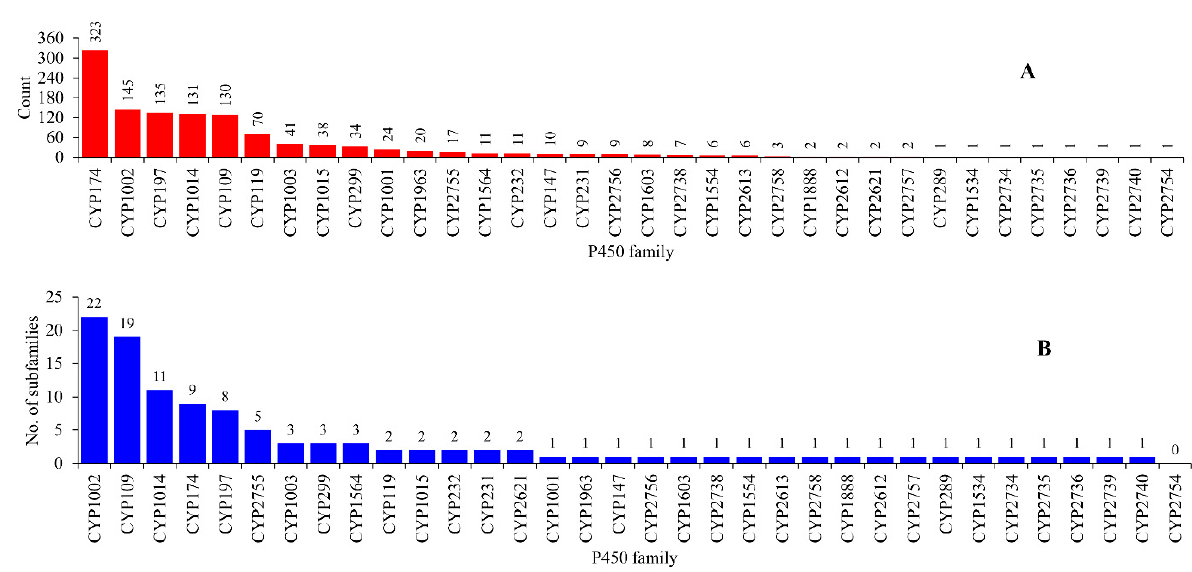
Figure 2. Comparative analysis of P450 families ( A ) and subfamilies ( B ) in archaea. The numbers next to the bars represent the member count for that family or subfamily. Detailed information is provided in Table S2.